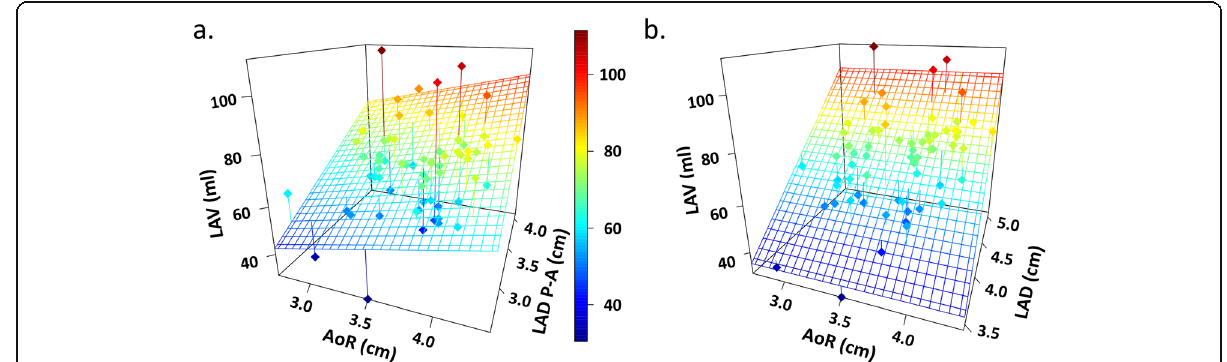
Fig. 3 3D plots comparing the impact of increasing AoR on LAV calculated using LAD P-A or LAD. A The 3D graph shows that LAD P-A is diminished when AoR diameter increases. B The 3D graph shows that the wide range of AoR has no influence on the linear correlation between LAV and LAD. The color code is linked to the “ severity ” of the atrial enlargement, then red indicates those cases that are “ at risk ” . In graph A , there are less “ severe ” cases, but this is obviously an artifact, or in other words a technical